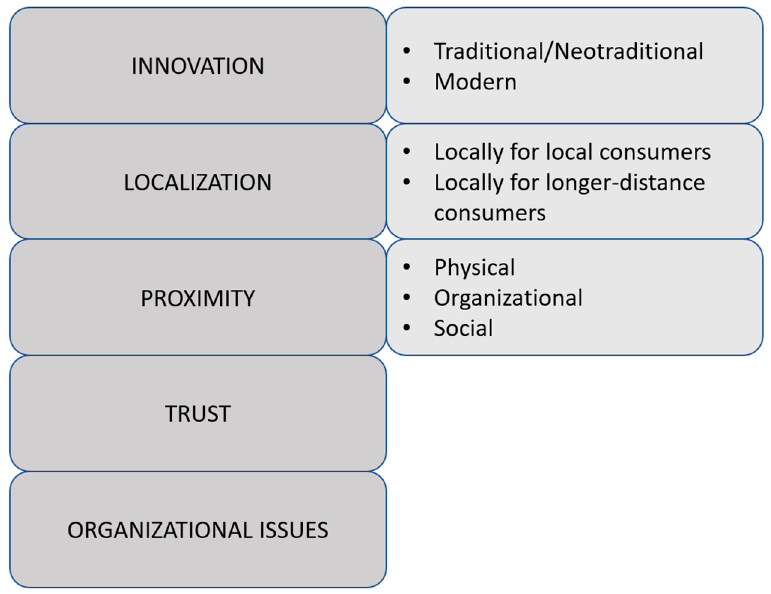
Figure 1. Approaches to classifying SFSC models.